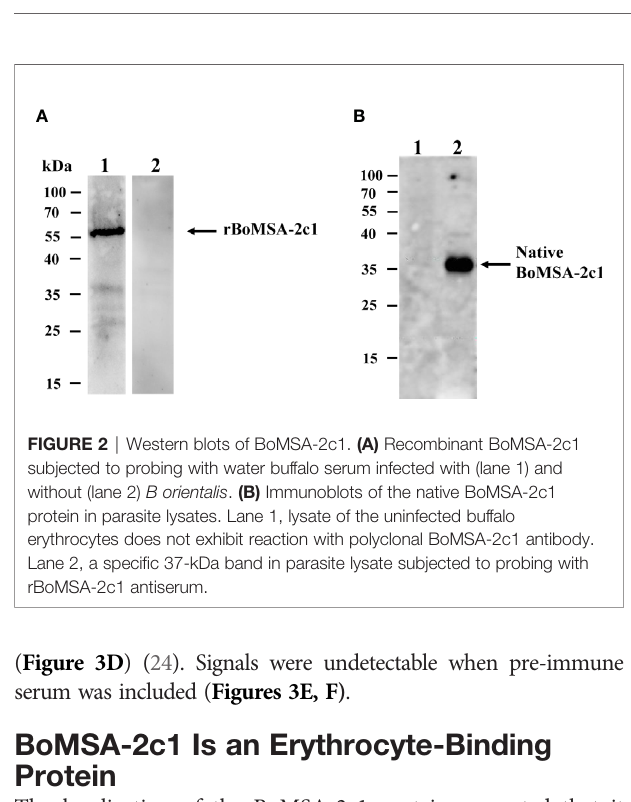
( Figure 3D ) (24). Signals were undetectable when pre-immune serum was included ( Figures 3E, F) .